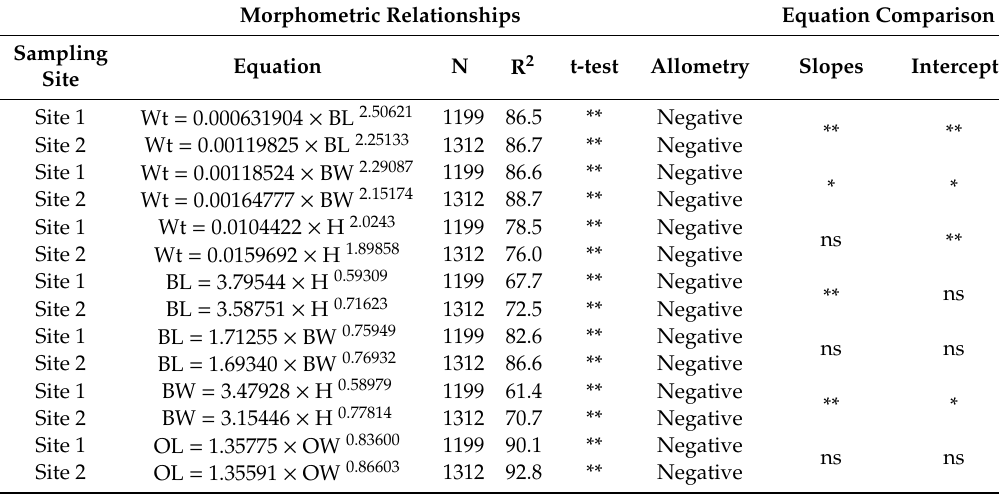
Table 3. Allometric equations between basal length (BL), basal width (BW), height (H), total weight (Wt), opercular length (OL), and opercular width (OW) of C. stellatus populations for sampling sites, Site 1 (exposed) and Site 2 (sheltered), during the study. N: number of individuals, R 2 : coe ffi cient of determination, t-test: statistical significance of the allometric relationship, allometry: allometric relationship between the two variables, slopes (b): statistical comparison between the slopes of the equations, intercepts (a): statistical comparison between the intercepts of the equations, significance level (ns: non-significant, *: p < 0.05, **: p <